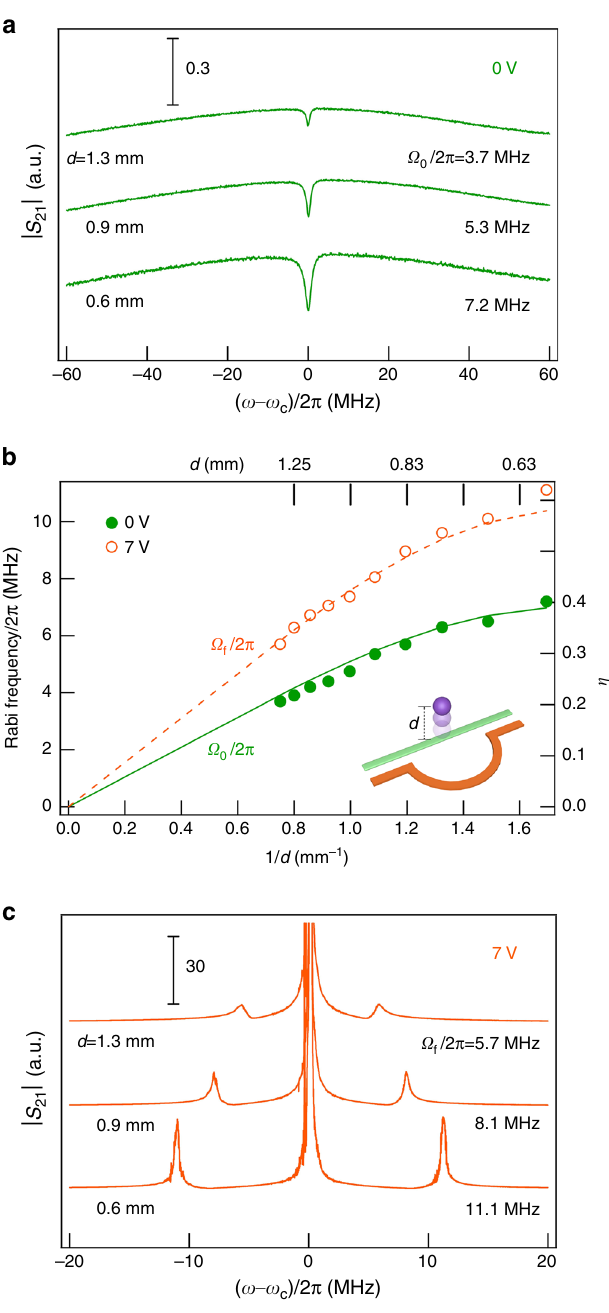
Fig. 2 Distance dependent Rabi frequency. a | S 21 | spectra measured at Δ = 0 and V = 0 V, for d = 1.3, 0.9, and 0.6 mm. The corresponding Rabi frequencies Ω 0 are determined by line shape fi tting. b Rabi frequency as a function of d . The solid (open) circles represent data measured at V = 0 V (7 V). The solid curve represents Ω 0 /2 π calculated from Eq. (1) by using η determined from a Maxwell ’ s equations solver, where the dashed curve is calculated with Ω f = 1.5 Ω 0 . c | S 21 | spectra measured at Δ = 0 and V = 7 V. The Rabi frequencies Ω f are determined from the mode splitting